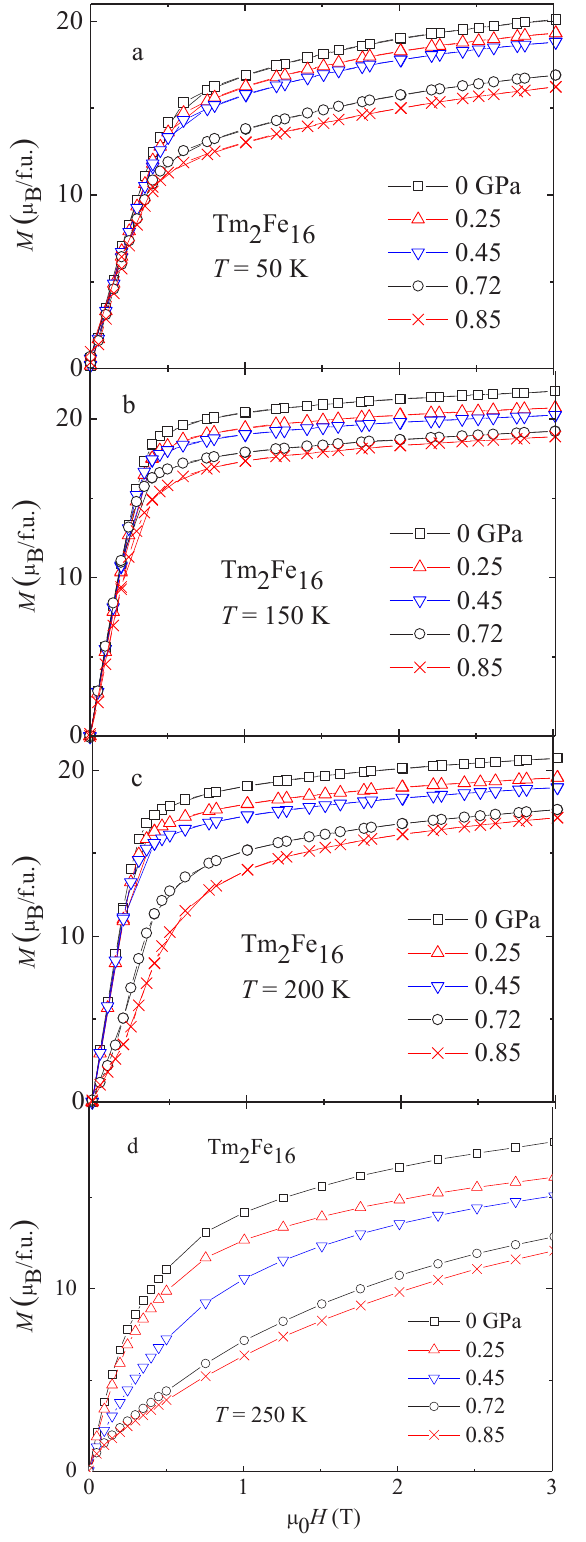
Fig. 2. Magnetic isotherms of Tm 2 Fe 16 measured at T = 50 K (a), 150 K (b), 200 K (c) and 250 K under pressures: 0, 0.25, 0.45, 0.72, 0.85 GPa (top-down).